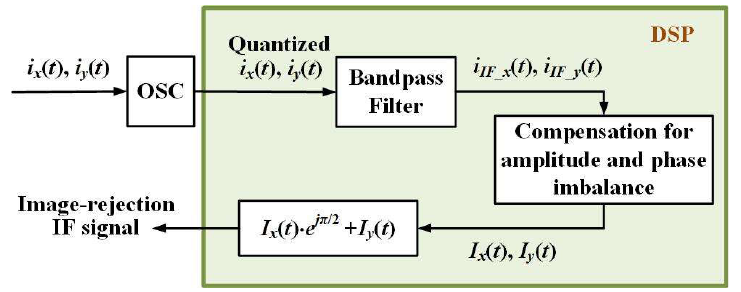
Figure 6. Flow chart of the imbalance compensation. OSC: oscilloscope; DSP: digital signal processing.